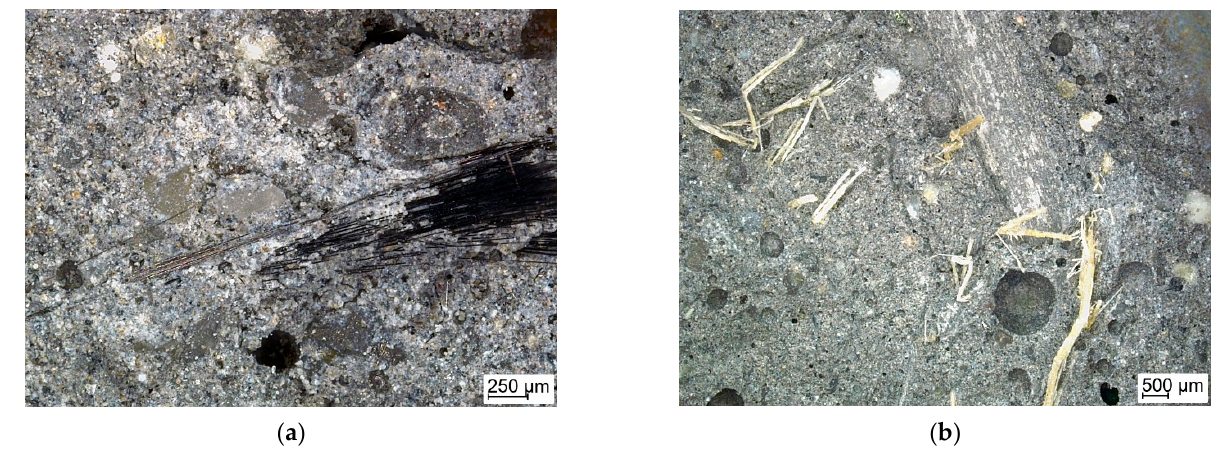
Figure 6. Structure of the composites reinforced with: ( a ) carbon fiber; ( b ) flax fiber.